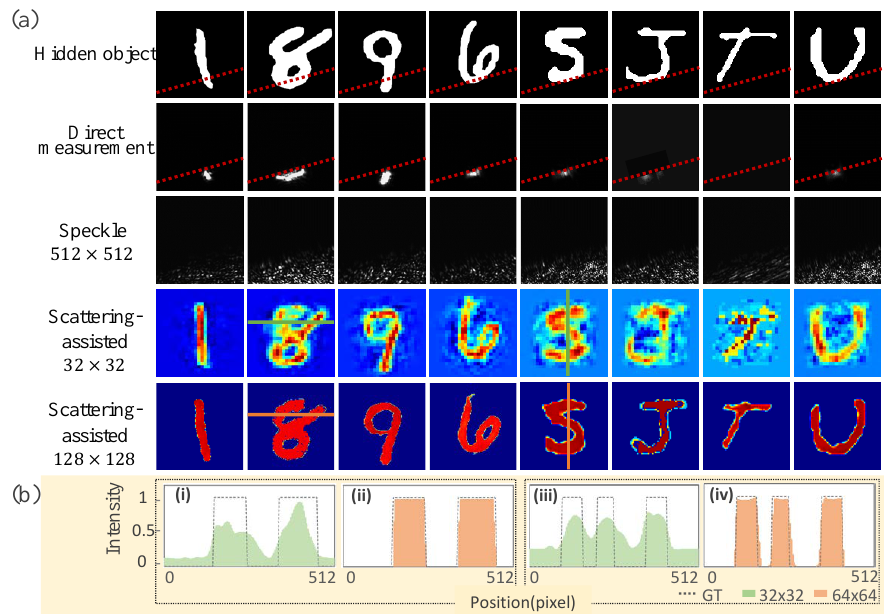
Figure 4. ( a ) The result of hidden object with both direct imaging and proposed scattering-assisted computational imaging method; ( b ) intensity plots from one line of objects corresponding to the intensity of ground truths (GT), where (i)–(ii) respond to the imaging results of ‘8’ using blocks with 32 × 32 and 128 × 128 pixels, respectively, and (iii)–(iv) respond to these of